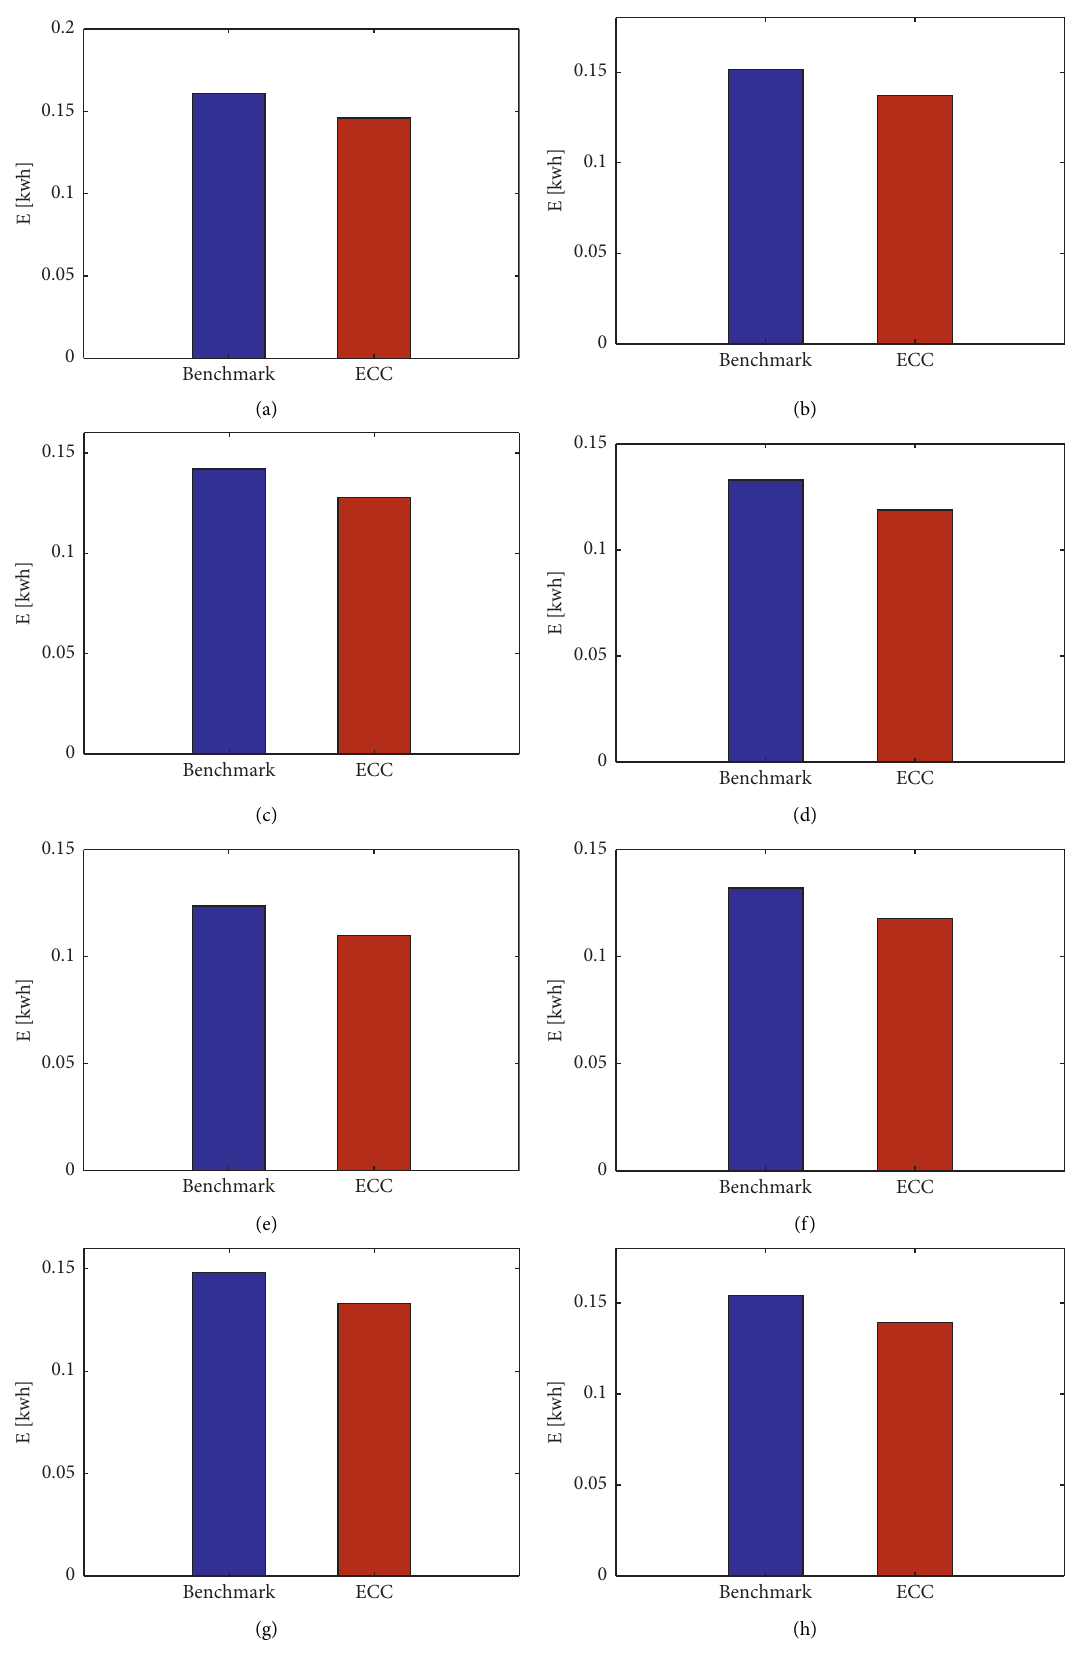
Figure 13: Energy consumption at different cruise speeds. (a) At 40km/h. (b) At 50km/h . (c) At 60km/h. (d) At 70km/h. (e) At 80 km/h. (f) At 90km/h. (g) At 100km/h. (h) At